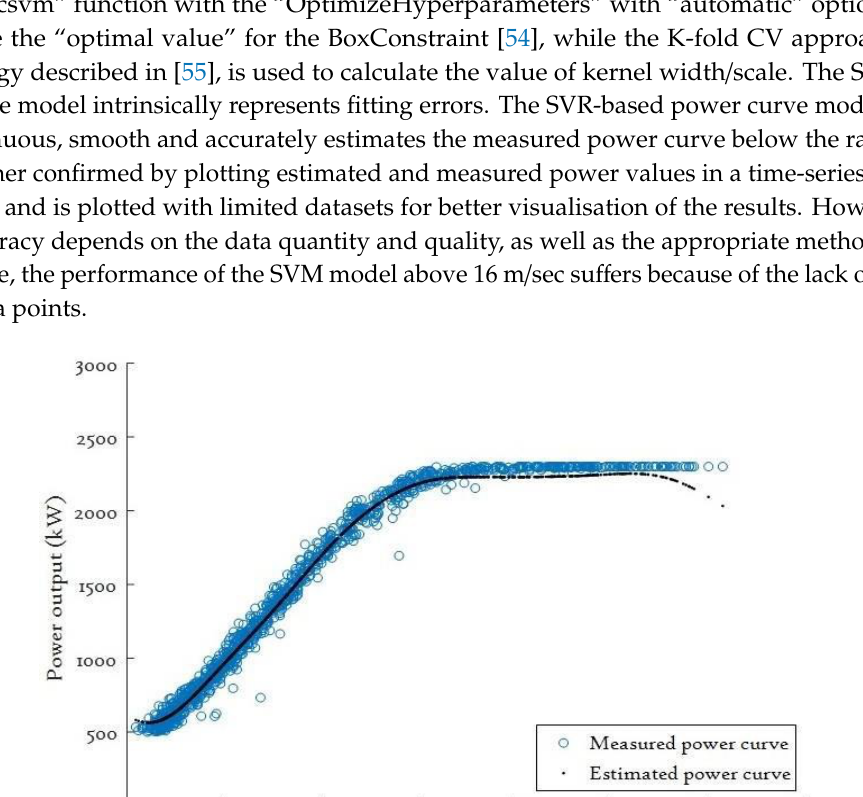
Figure 5. Comparative studies of SVM power curve model in terms of time-series.